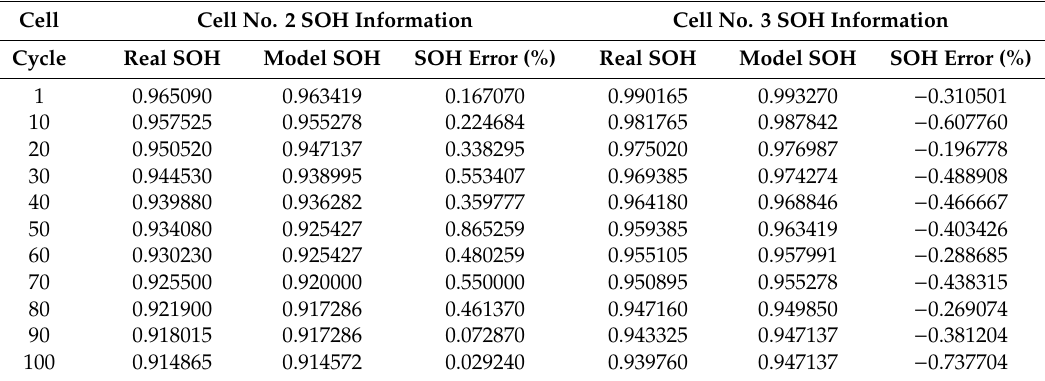
Table 2. Numerical results for comparison between the linear regression model based on the partial capacity of cell no.1 and a real SOH based on two partial capacities of cell nos. 2 and 3 (SOH error = Real SOH − Model